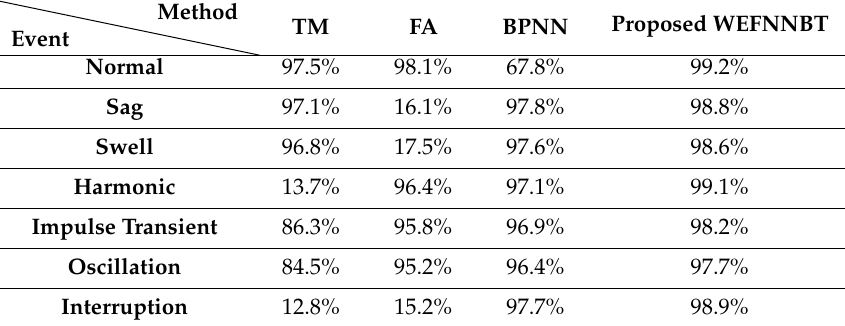
Table 4. Comparison of identification accuracy.